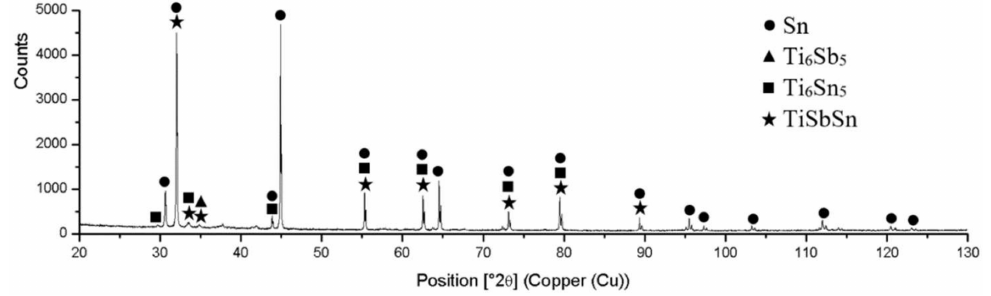
Figure 6. XRD analysis of Sn5Sb3Tisolder